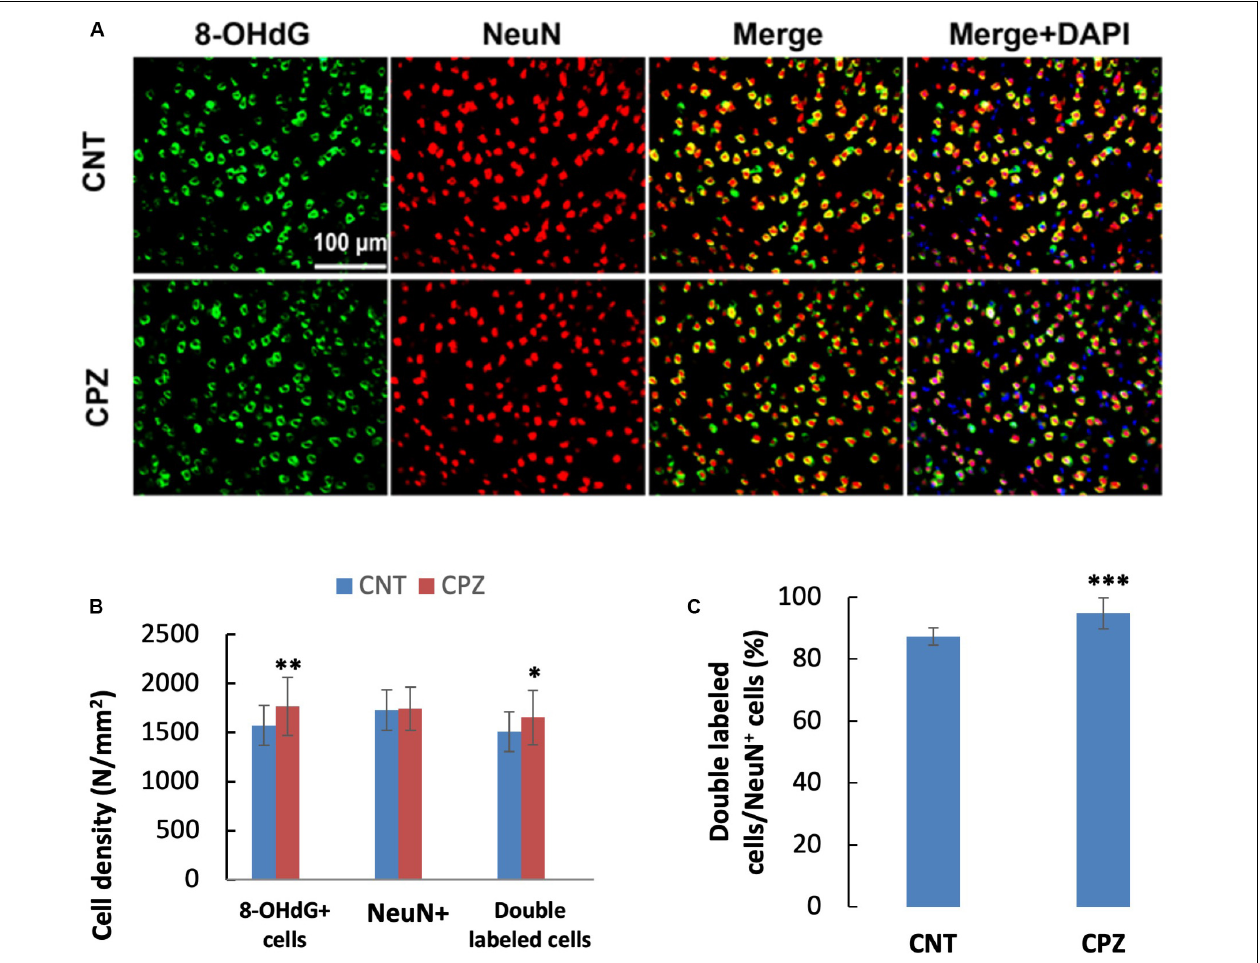
FIGURE 5 | (A) Representative photographs showing cells labeled by the antibody to 8-OHdG, antibody to NeuN, and double labeled cells by the two antibodies. (B,C) Bar charts showing the statistical analysis results of the immunofluorescent staining. Data are expressed as means ± SD ( n = 6/group). * p < 0.05, ** p < 0.01, *** p < 0.0001. The comparisons were made between CNT and CPZ groups by performing t -test or chi-square test (percentage of double labeled cells in NeuNi +